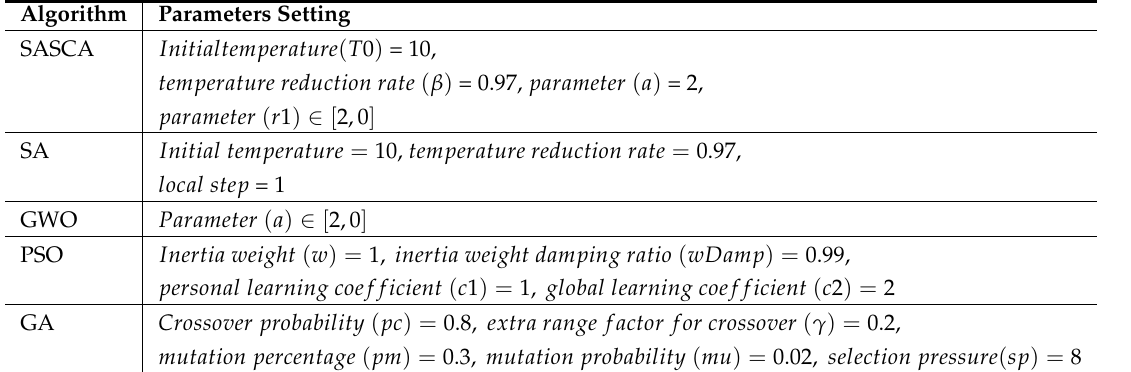
Table 1. The parameters setting of the proposed